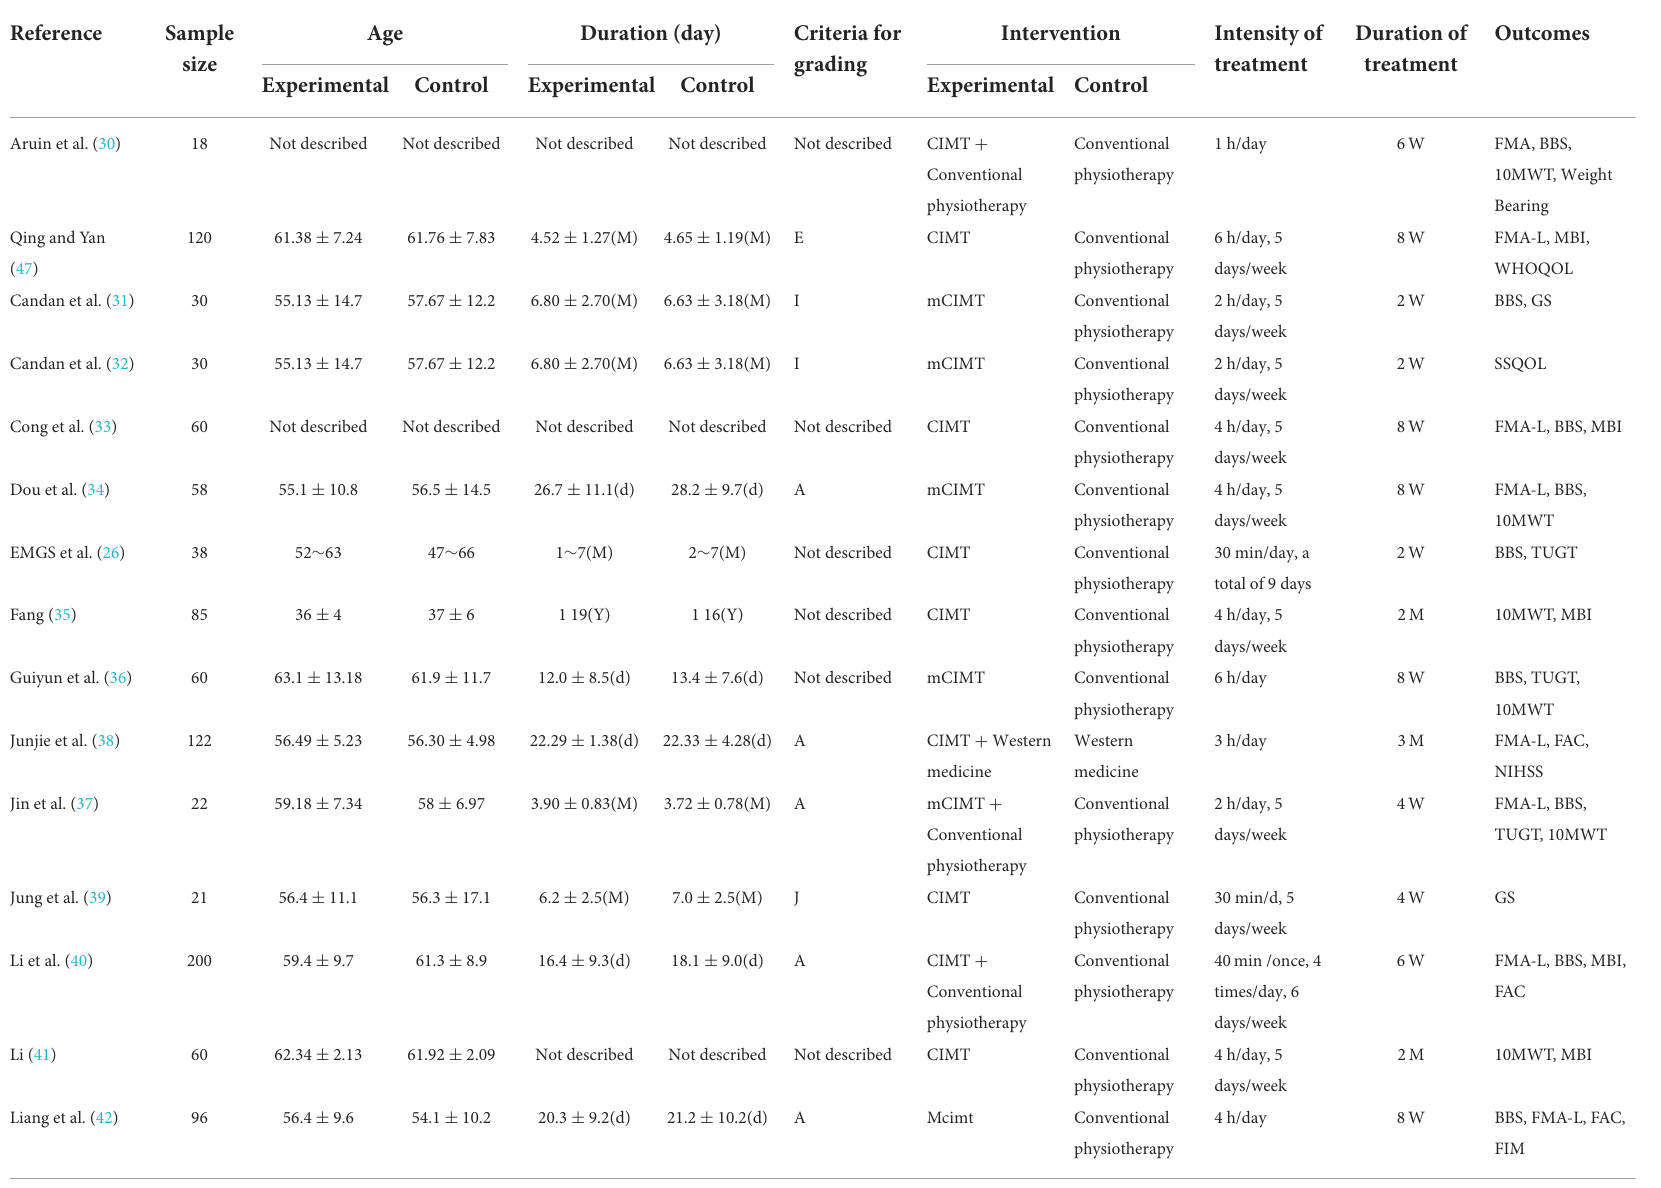
TABLE 1 Characteristics and details of interventions of included